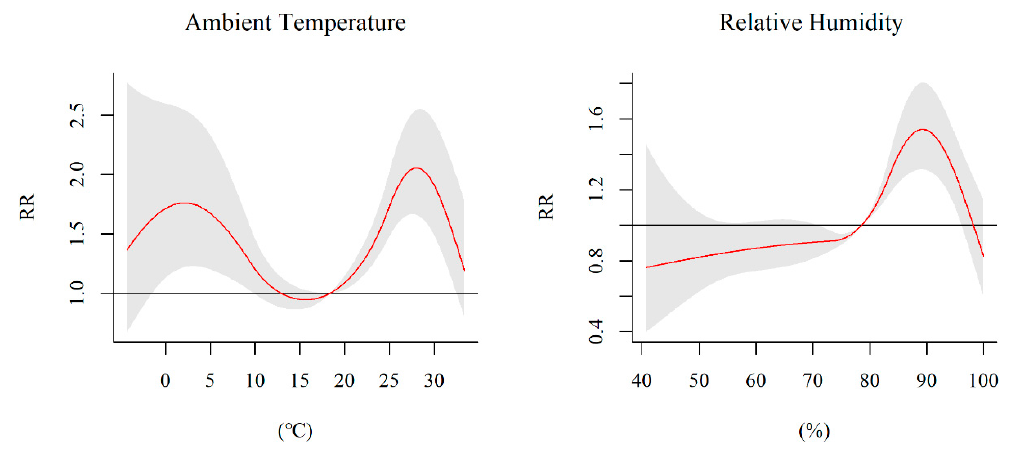
Figure 3. Cumulative effects of ambient temperature and relative humidity on HFMD incidence within 14 days.